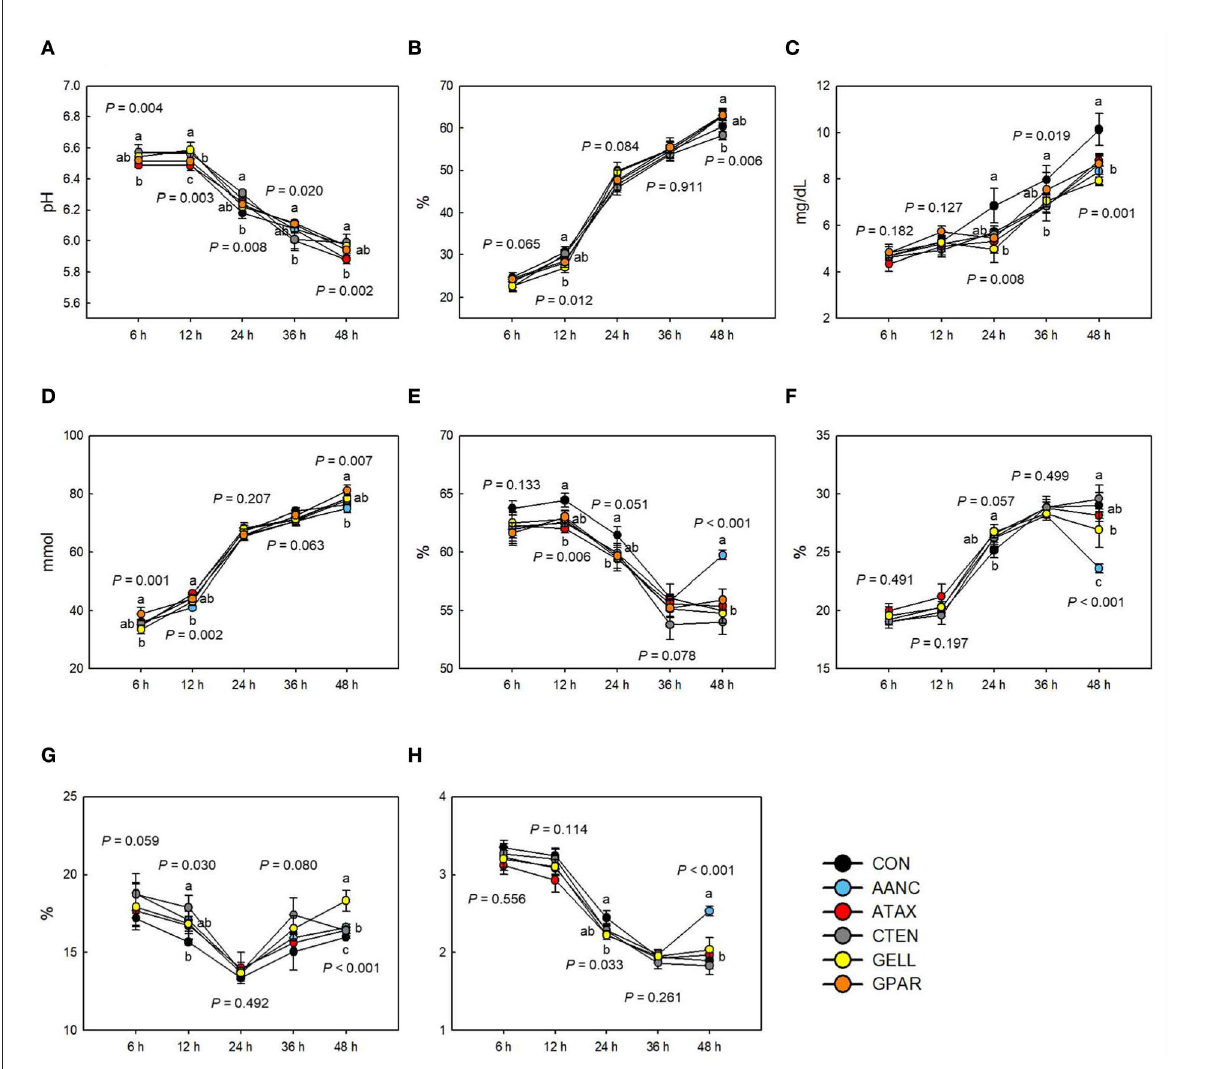
FIGURE2 Effects of red seaweed extracts on in vitro fermentation characteristics. IVDMD, in vitro dry matter degradability; NH 3 -N, ammonia nitrogen; VFA, volatile fatty acid; AP, acetate to propionate; CON (black circle), without seaweed extracts; AANC (sky blue circle), Amphiroa anceps ; ATAX (red circle), Asparagopsis taxiformis ; CTEN (dark gray circle), Chondracanthus tenellus ; GELL (yellow circle), Grateloupia elliptica ; GPAR (orange circle), Gracilaria parvispora. Data were analyzed using seaweed extracts dose amount: 0.25 mg/mL, based on a 5% basis of substrate mixture. Bars represent the standard error of triplicate analysis. P -values represent multiple comparison output of each incubation time. a − c Means with different superscript letters indicate a significant difference ( P < 0.05). (A) pH, (B) IVDMD (%), (C) NH 3 -N (mg/dL), (D) Total VFA (mmol), (E) Acetate (%), (F) Propionate (%), (G) Butyrate (%), and (H) AP